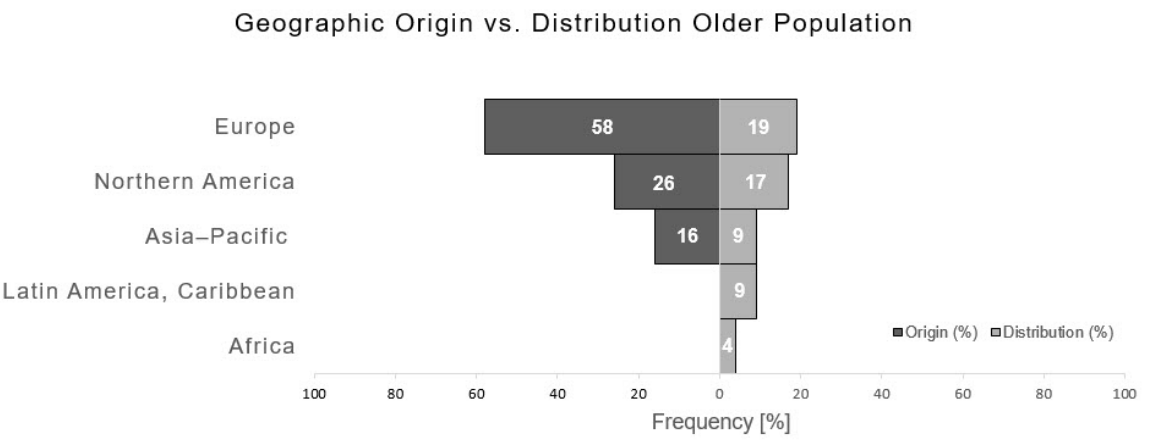
Figure 3. Geographic origin of publications in relation to proportion of older population. Within Europe, most publications were from Italy ( n = 7), followed by Germany ( n = 6), United Kingdom ( n = 3) and Switzerland ( n = 3), Austria ( n = 2), Ireland ( n = 2); Spain, France, Greece, the Netherlands, and Sweden reported one article each (Figure 4).